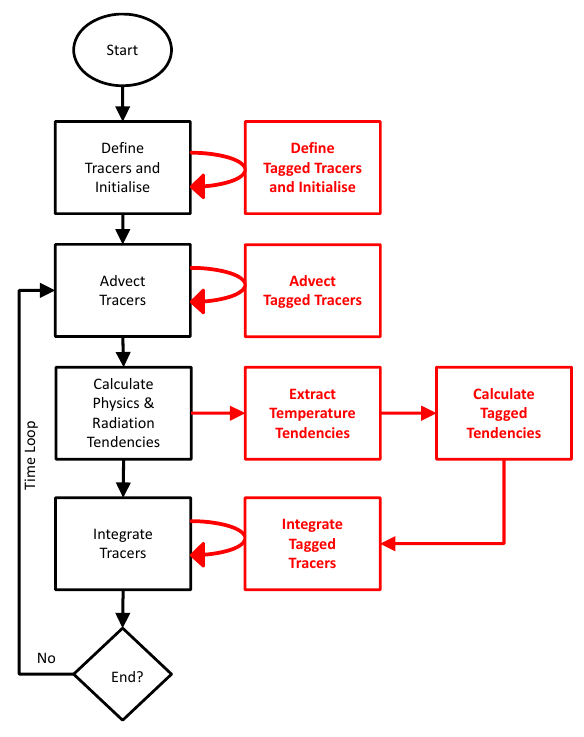
Fig. 10. Principle flowchart of a climate model (black) and neces- sary extensions for a temperature tagging scheme